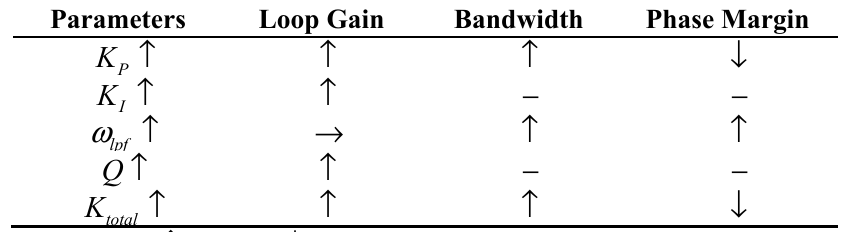
Table 1. Performance specifications of the control loop versus primary system parameters.